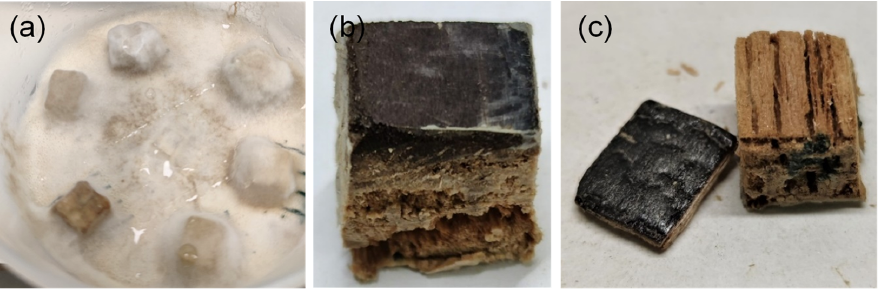
Figure 1. ( a ) Spruce references on C. puteana prior to cleaning and mass loss determination; ( b )